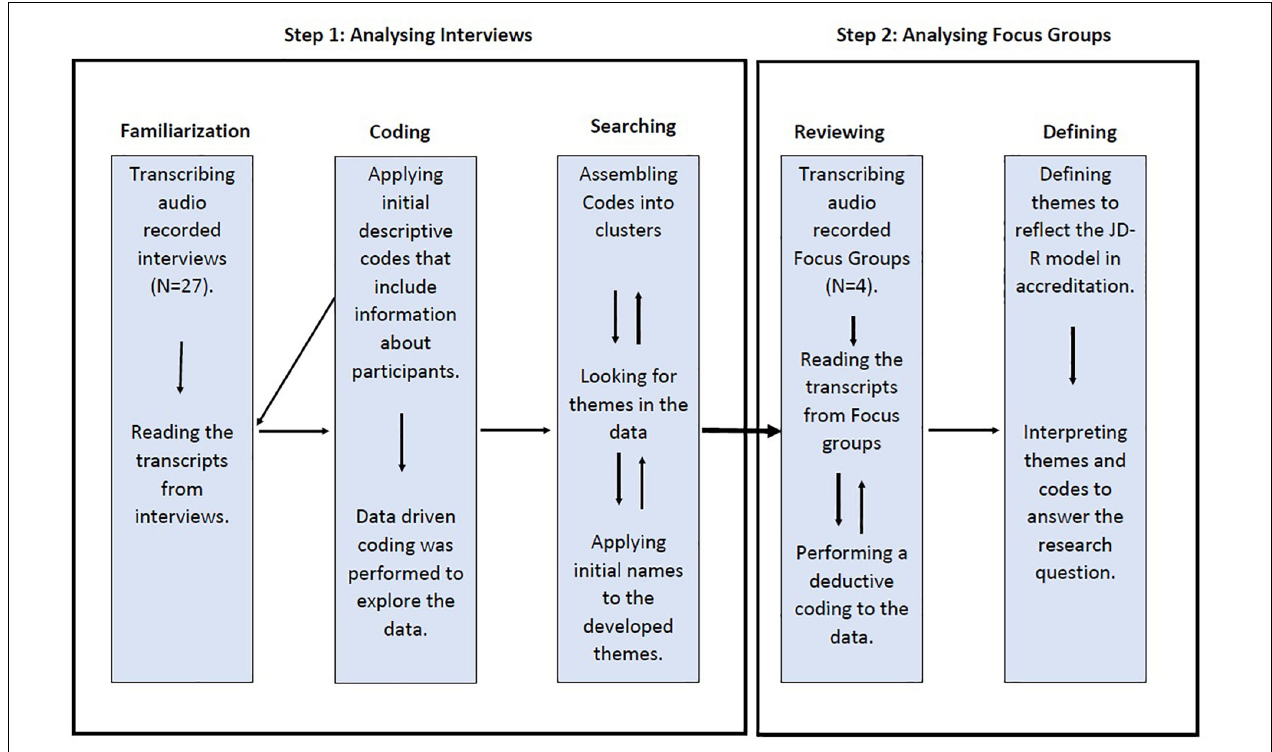
FIGURE 1 | The process of analyzing interviews and focus group